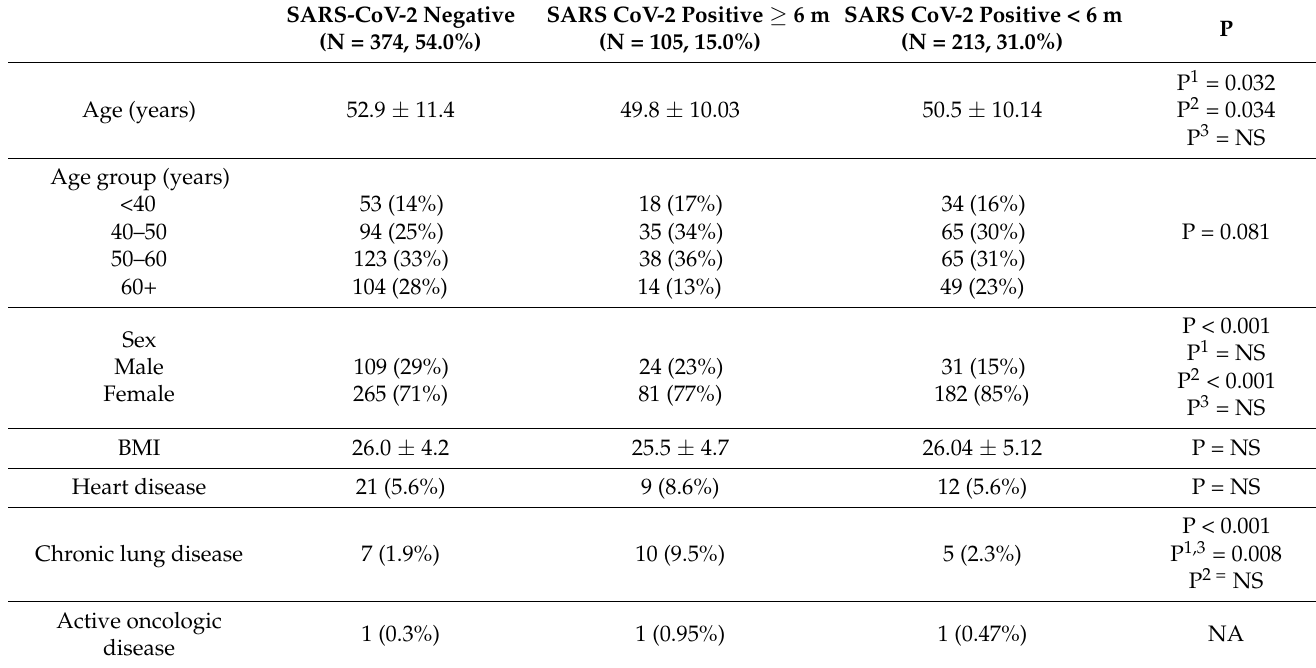
Table 2. Comparison between HCWs who were not infected with SARS-CoV-2, HCWs who became infected within 6 months of the last vaccine dose, and HCWs who became infected later than 6 months after the last vaccine